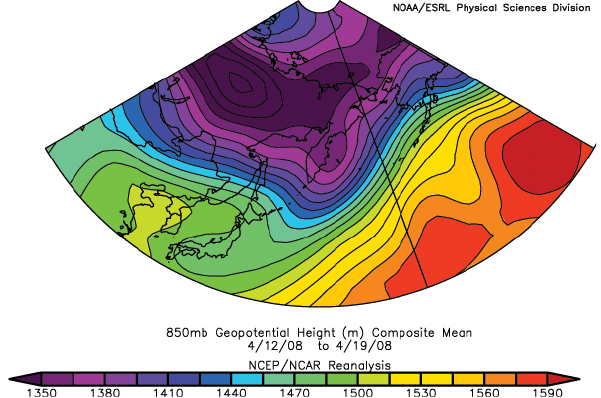
Fig. 19. Mean 850hPa geopotential height (m) pattern, 12–19 April